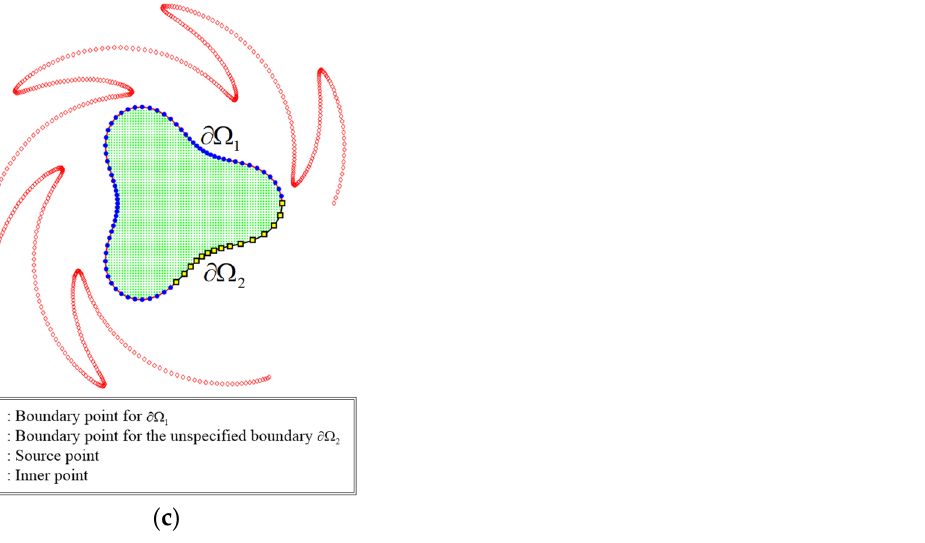
Figure 2. Scenarios for locating the sources: ( a ) First scenario; ( b ) second scenario; ( c ) third scenario.